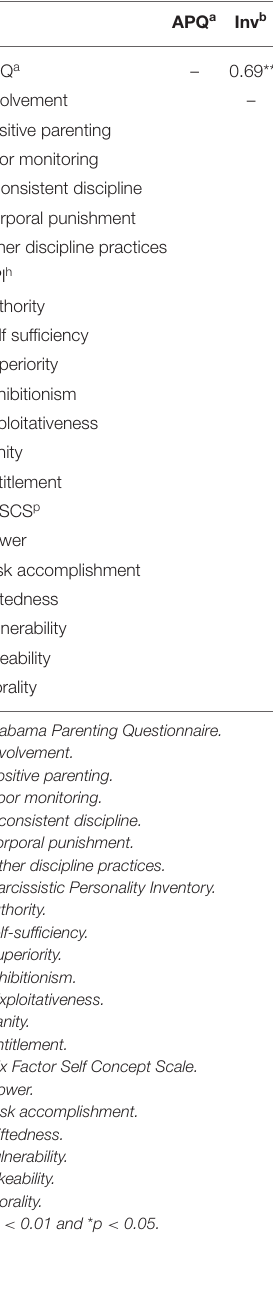
TABLE 3 | Correlation matrix between subscales of APQ, Narcissistic Personality Inventory and its subscales, and SFSCS and its subscales ( N =